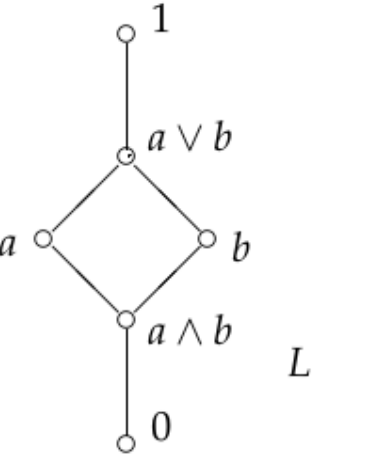
Figure 2. A lattice with normal elements possible determined by two